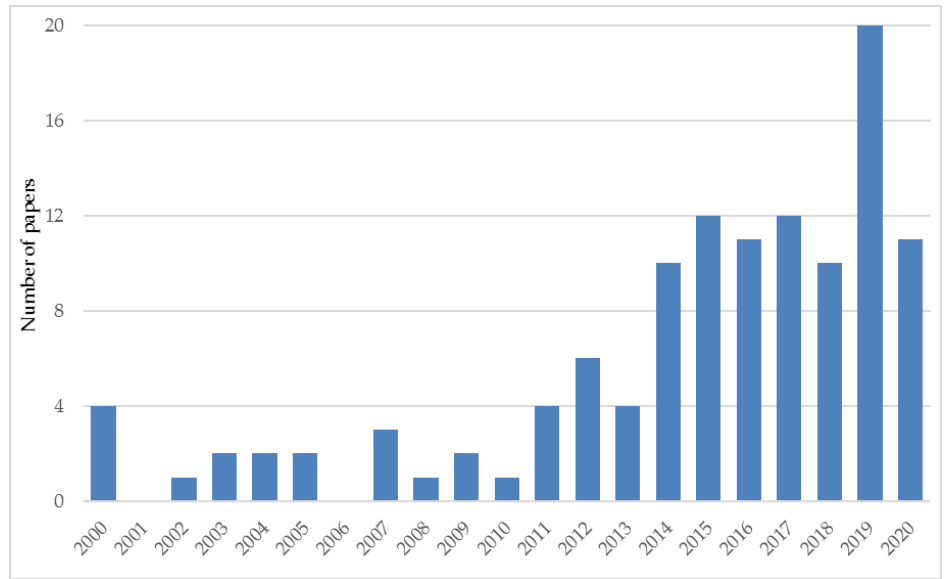
Figure 1. The number of peer-reviewed Silphium perfoliatum –related scientific papers in 2000–2020.